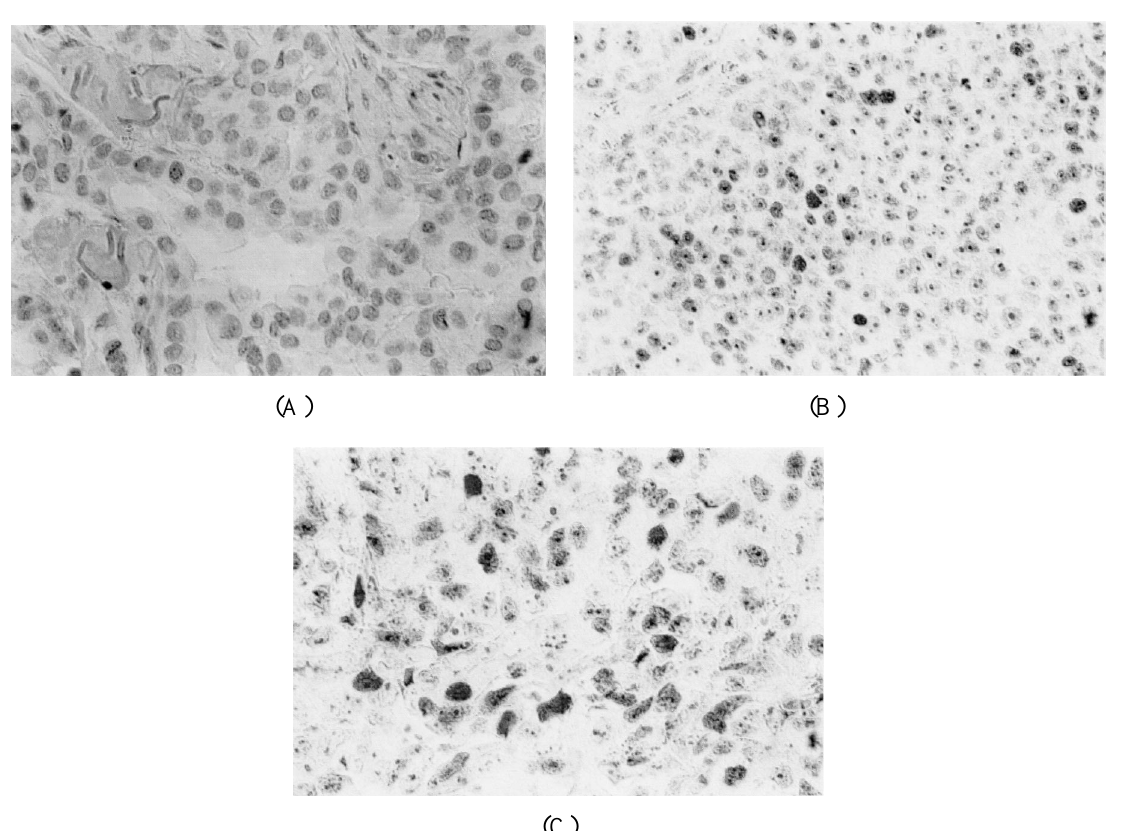
Fig. 2. Examples of cyclin E immunohistochemical stainings of primary breast cancers. The fraction of cyclin E postive cells were 8% in (A), 63% in (B) and 69% in (C) and the cyclin E intensity of the most intensely stained tumour cells estimated to 2 + (intermediate) in (A) and 3 + (high) in (B) and (C). The total amount of cyclin E determined by Western blotting was 0.09 in (A), 2.43 in (B) and 4.65 in (C). Tumours (A) and (C) had normal pRB, tumour (B) defect